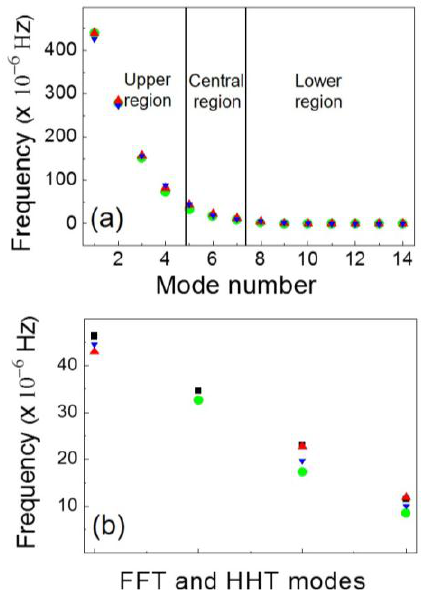
Figure 5. ( a ) HHT-EMD frequencies for the active power P of L 1 , L 2 and L 3 subdivided into the three frequency regions (upper, central and lower) of the HHT spectrum. Green circles: HHT frequencies for P 1 . Red up triangles: HHT frequencies for P 2 . Blue down triangles: HHT-EMD frequencies for P 3 ; ( b ) main FFT frequencies compared to the HHT-EMD frequencies of the central region for the active power of L 1 , L 2 and L 3 . Black squares: FFT harmonics H 1 , H 2 , H 3 and H 4 . The meaning of the other symbols is the same as in panel ( a ).